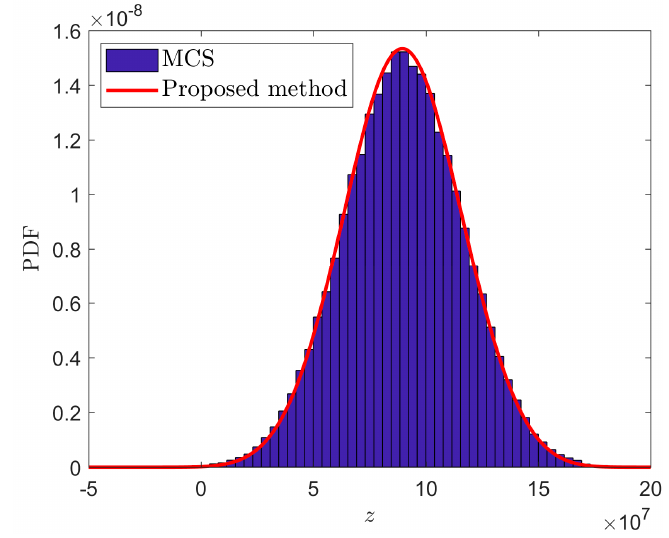
Figure 4. PDF curve of the proposed method and MCS method at t = 30.